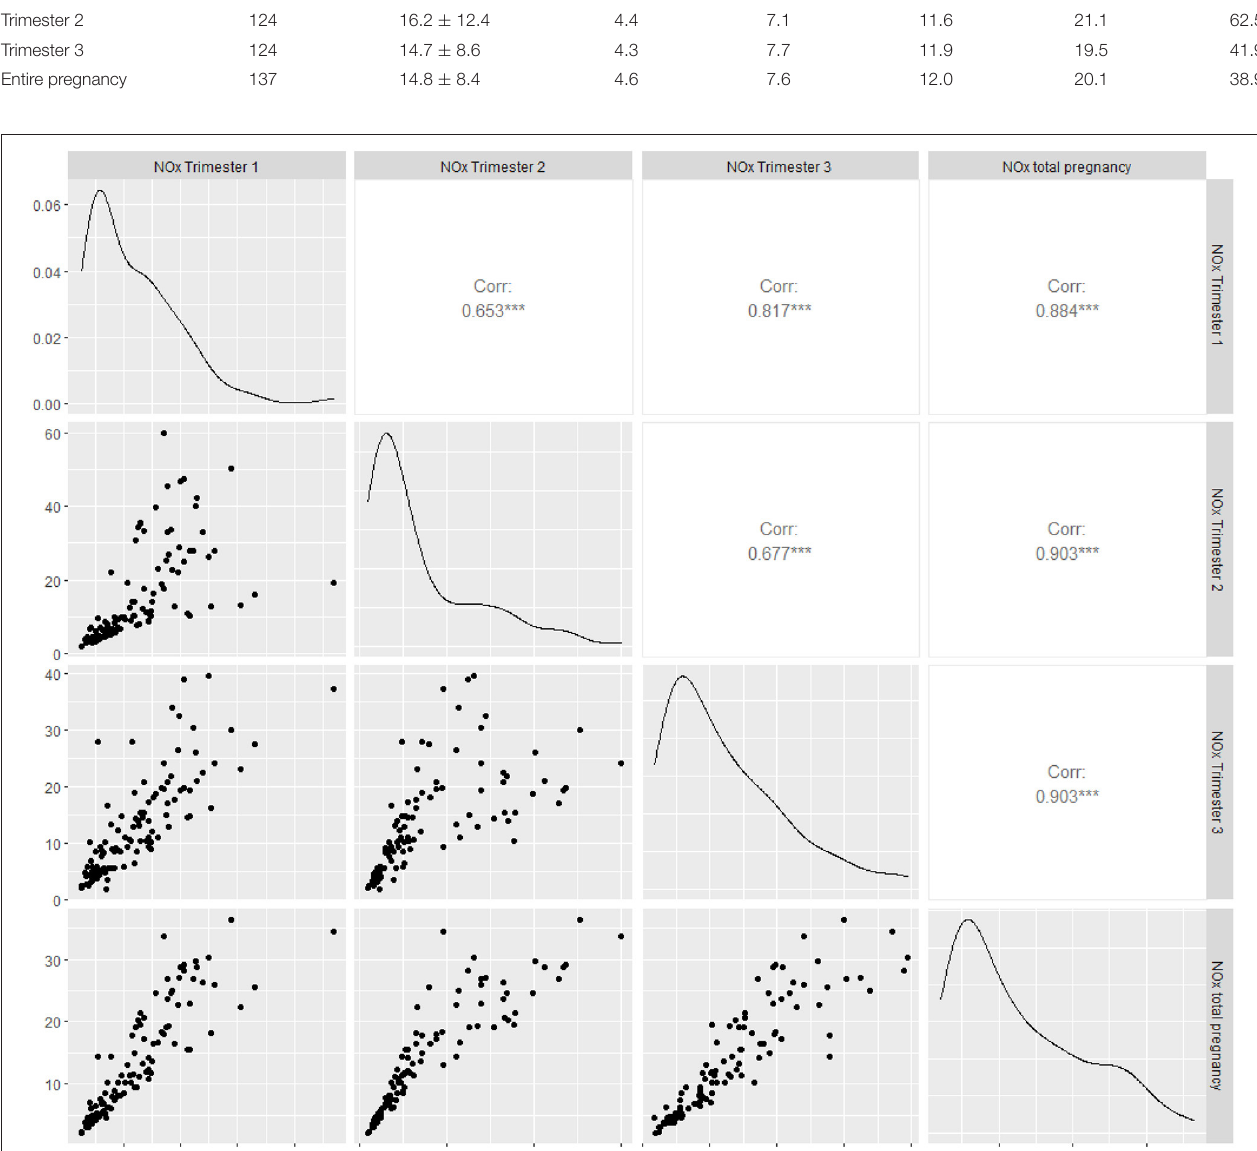
FIGURE 3 | Correlation plot of NO x concentrations at all trimesters and entire period of pregnancy.